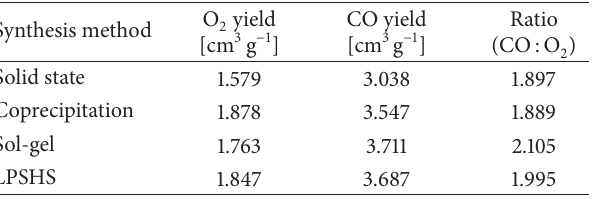
Table 1: CO and O yield for the 5th cycle for the four samples 2 prepared with different synthesis methods.